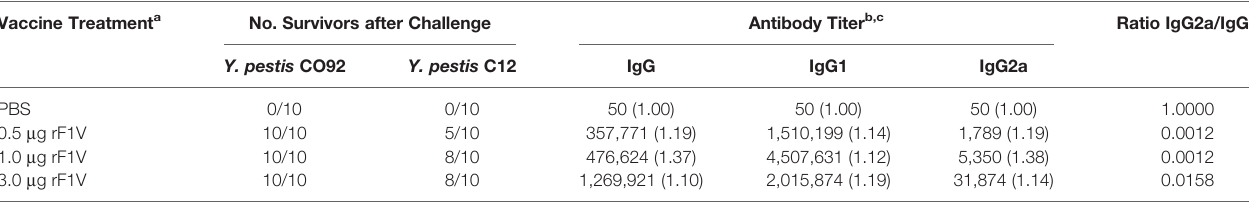
a Two subcutaneous vaccinations. b n was 4 for each group of mice. c Antibody titer 28 days after vaccination. Reported as geometric mean (Geo Mean) with geometric standard error